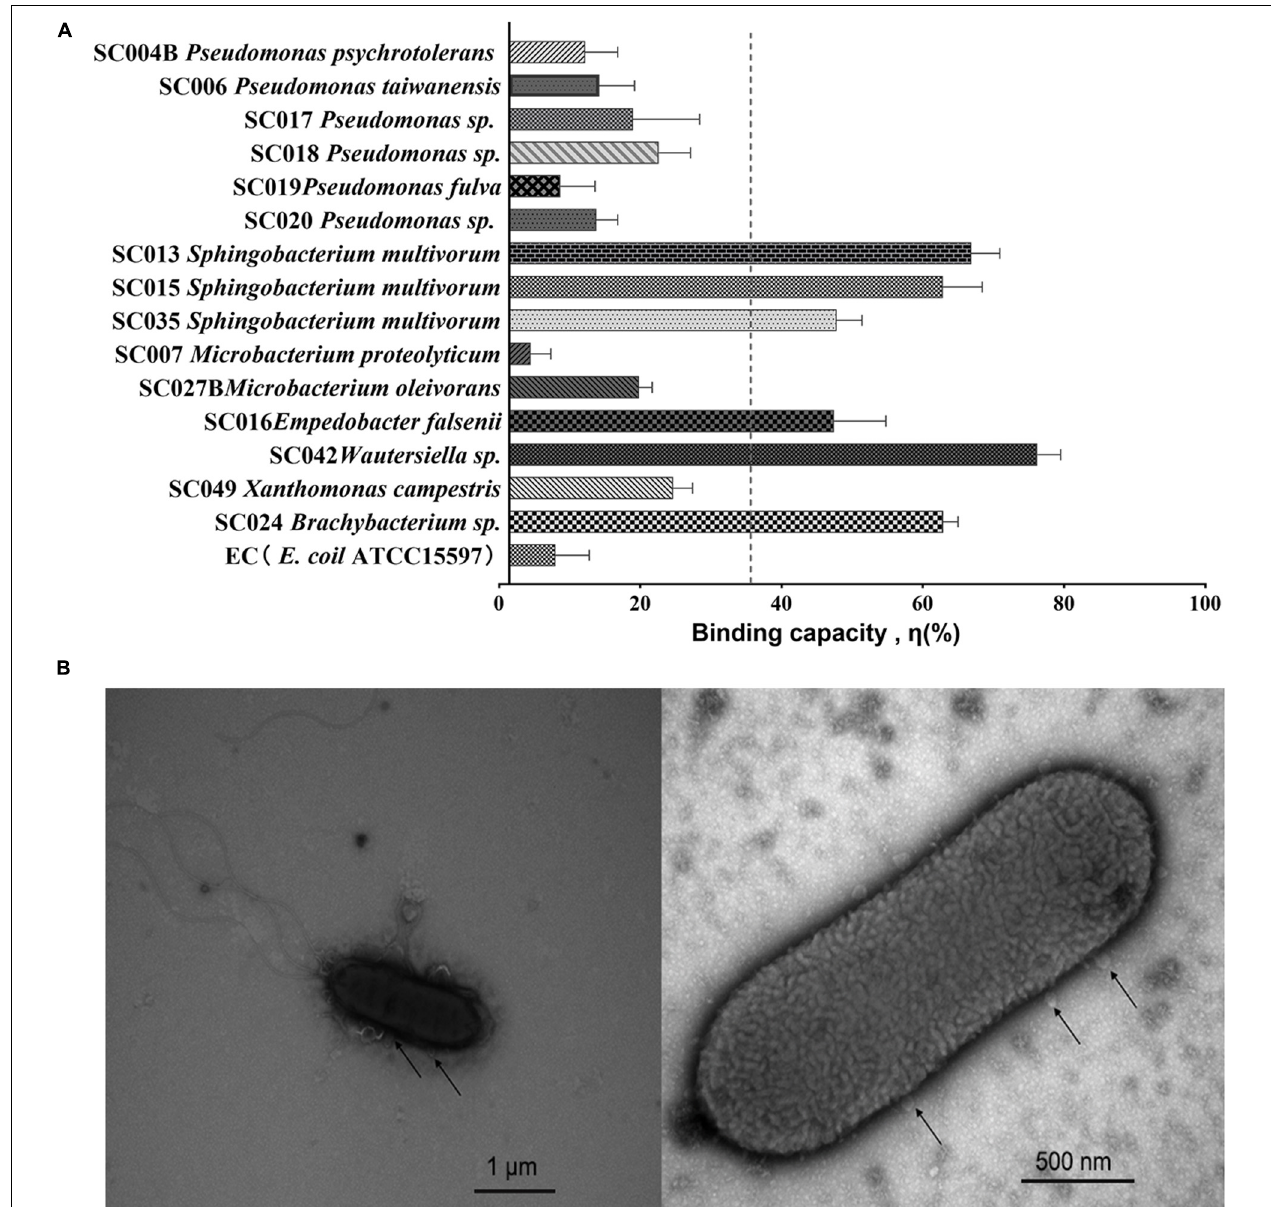
FIGURE 1 | Viral–bacterial binding between noroviruses (NoVs) and HBGA-SEB. (A) Binding capacity η (%) of HBGA-SEB strains to NoVs; the EC is the bacterial control of Escherichia coli ATCC15597, which has no HBGA-like substance expression; the average binding capacity η mean = 34.22% is marked as the vertical dash line. (B) Transmission electron microscopy (TEM) images indicate the direct binding between SC042 cells and NoV (GII.4)